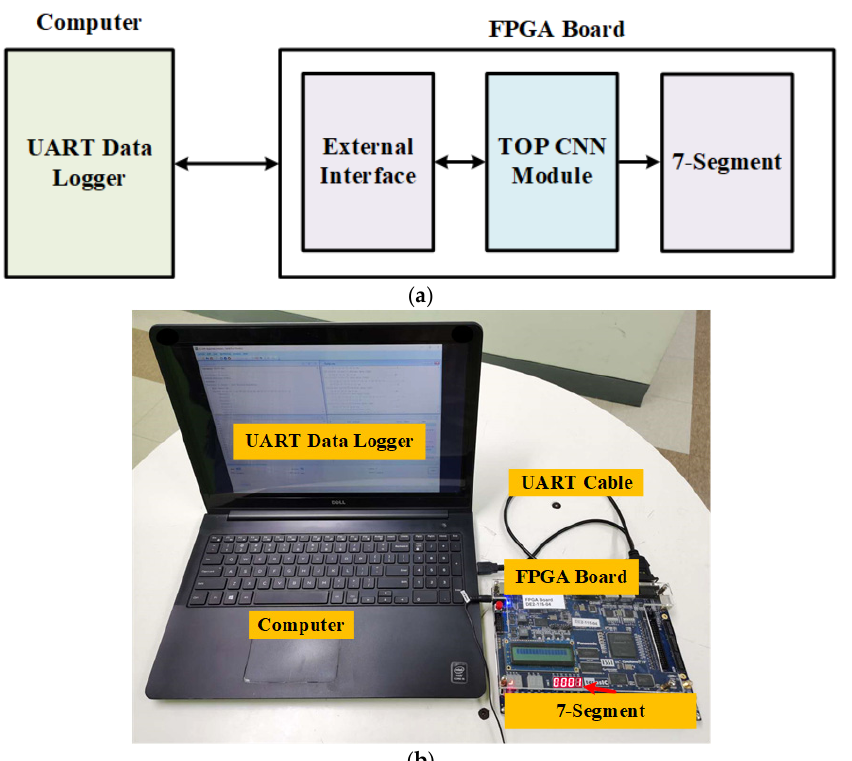
Figure 23. The proposed CNN system measurement setup. ( a ) The proposed CNN system measurement setup block diagram. ( b ) Measurement setup on FPGA.